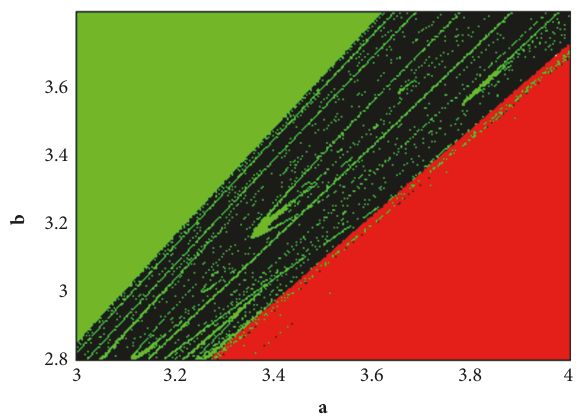
Figure 2: (Color online) Two-parameter (𝑎, 𝑏) bifurcation diagram depicting the dynamical behaviors of system (1a), (1b), and (1c). Unbounded orbits are in red; periodic oscillations are in green and chaos is in